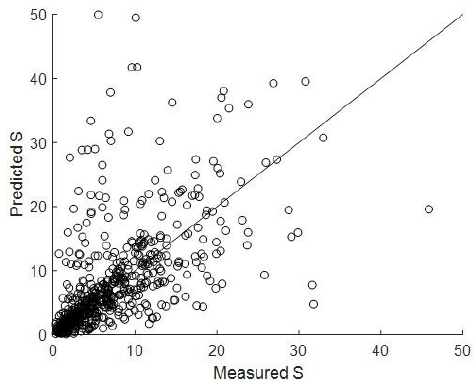
Figure 1. A comparison between the measured and the predicted damage levels by Van der Meer’s formula.